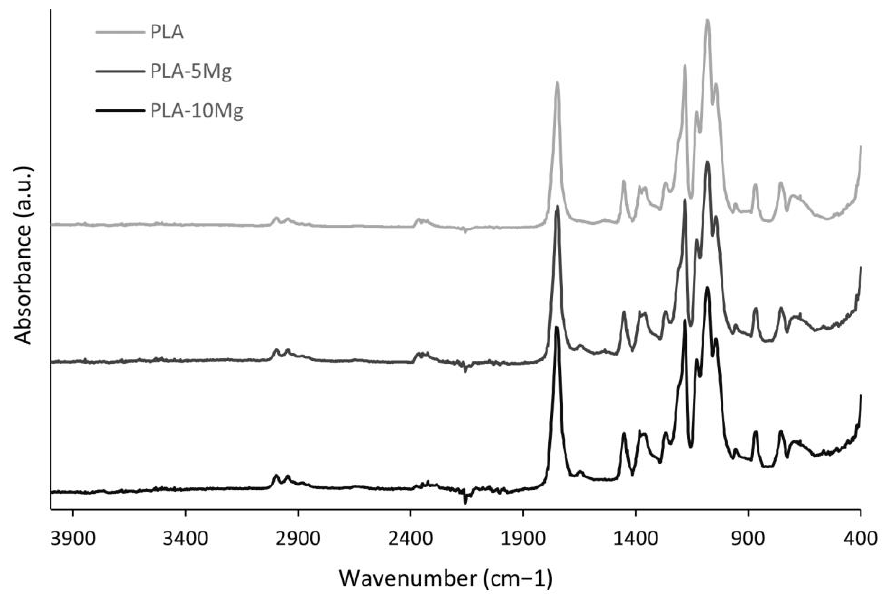
Figure 6. FTIR spectrum of PLA, PLA-5Mg, and PLA-10Mg.